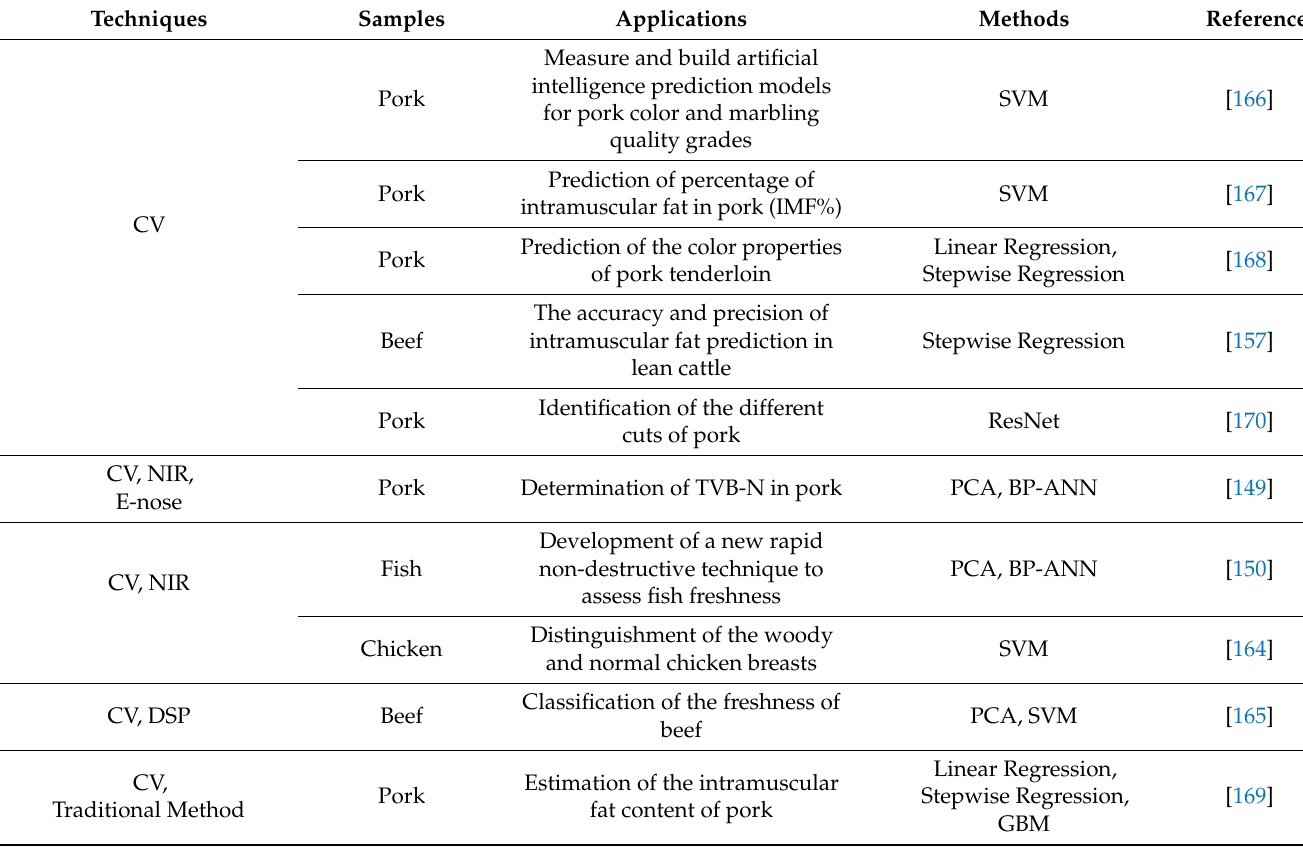
Table 4. Summaries of different data processing methods in machine vision systems applied for meat